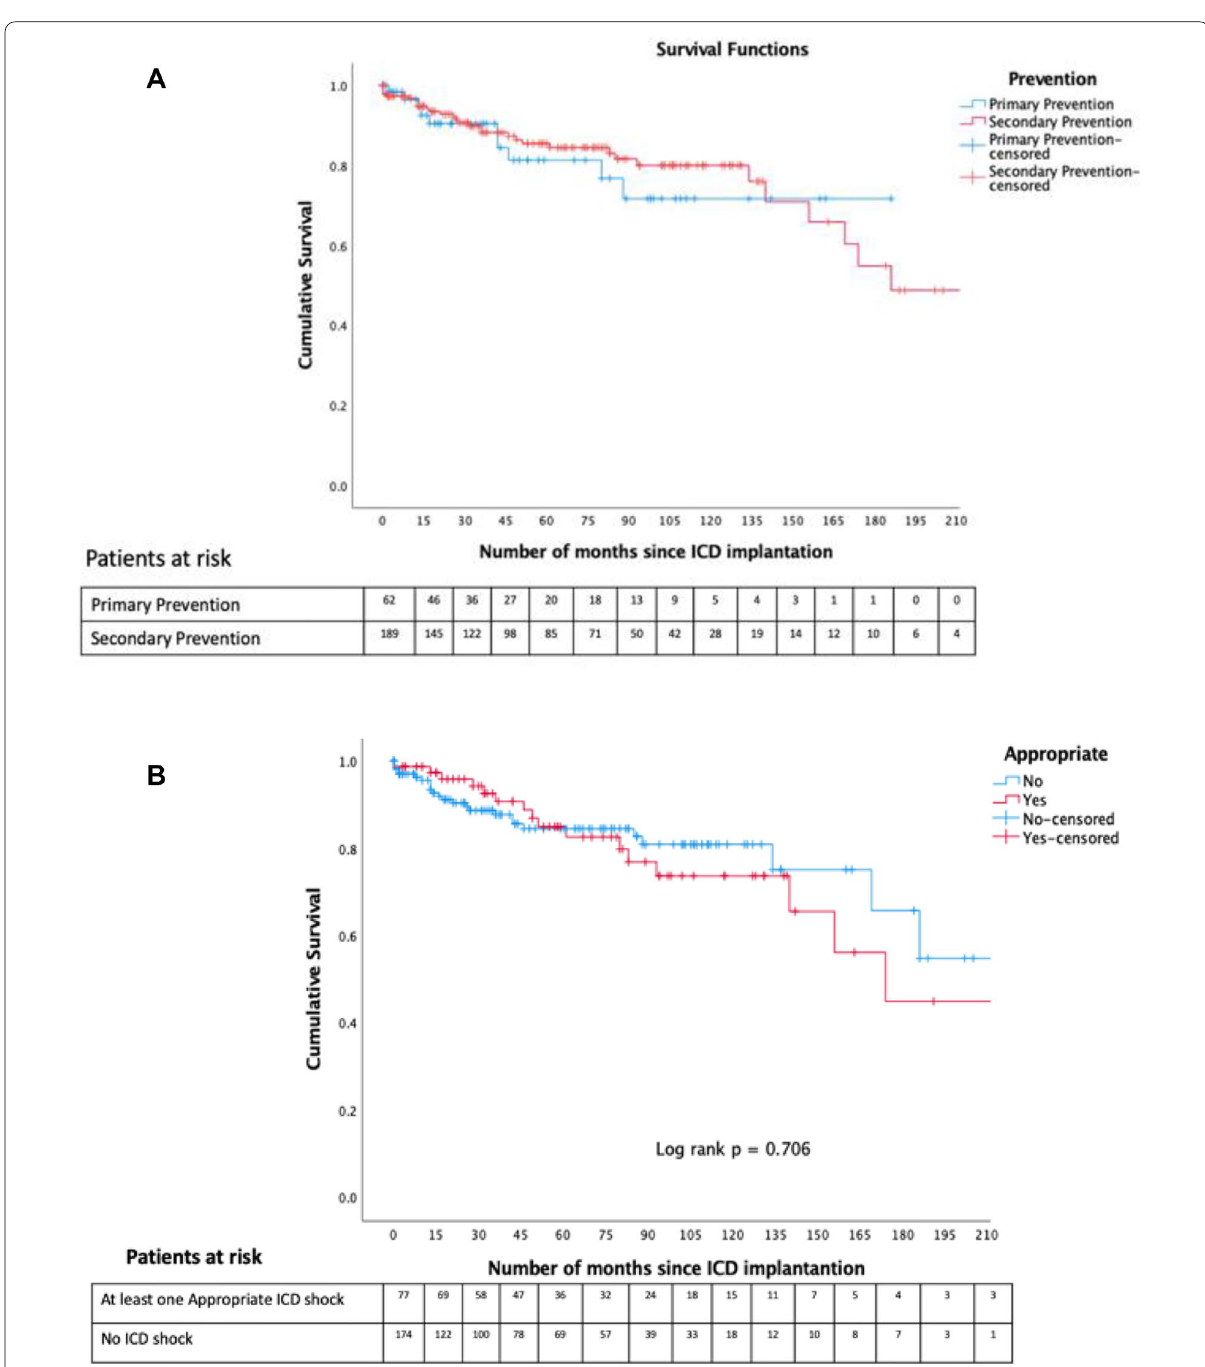
Fig. 3 A Kaplan Meier curves demonstrating cumulative survival difference between patients with primary prevention and secondary prevention devices. B Kaplan Meier curves demonstrate survival difference between patients who received at least one appropriate ICD shock during follow versus no ICD